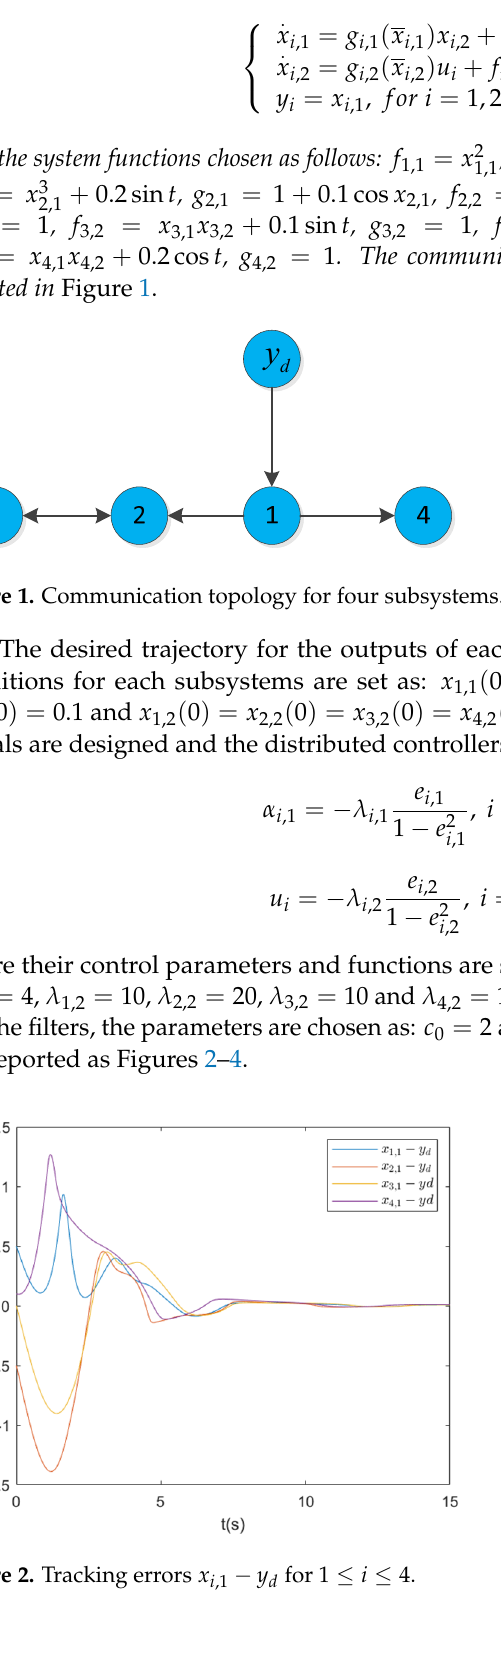
Figure 3. Outputs ,1 i x for 1 4 i ≤ ≤ and d y . Figure 4. Distributed control inputs i u for 1 4 i ≤ ≤ .